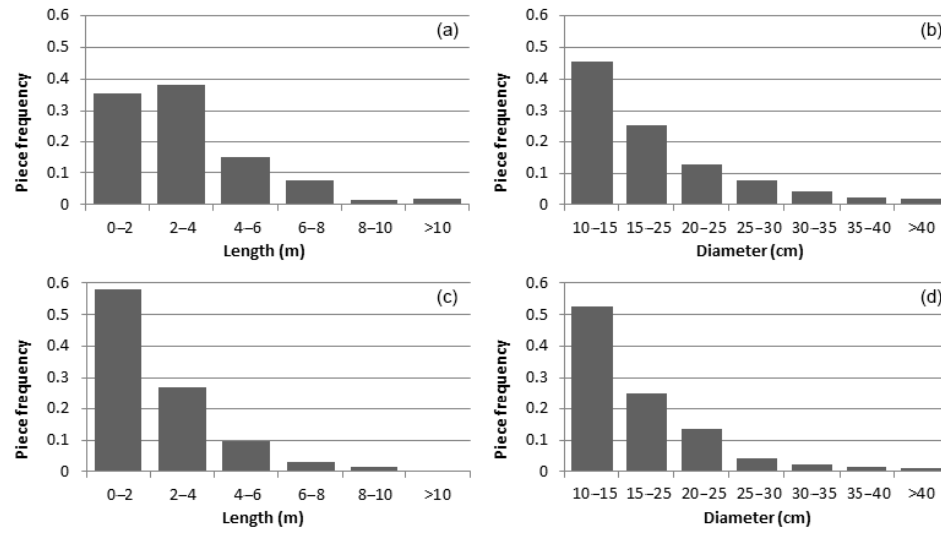
Figure 11. Size distribution (piece diameter and length) of deposited LW pieces in the Sädelgrabe (a–b) and in the Emme River (c–d) . In all panels the bars relate to the relative frequency of